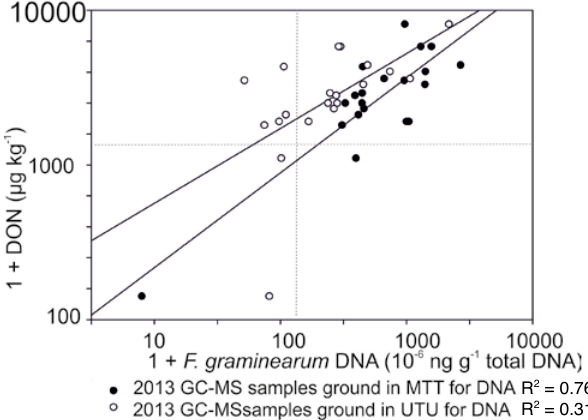
R 2 = 0.71*** R 2 = 0.76*** R 2 = Figure 2. Correlation between log Fusarium graminearum DNA and log deoxynivalenol (DON) concentrations in Finnish oat grain samples in 2013. DON level was esti- mated using the RIDA® QUICK SCAN. Oat samples were ground by a milling company for DON analysis, or by Turku University without sieving for DNA extraction. Re- gression slopes and R2 (coefficient of determination) values are shown. *** indicates statistically significant ( P <0.001)